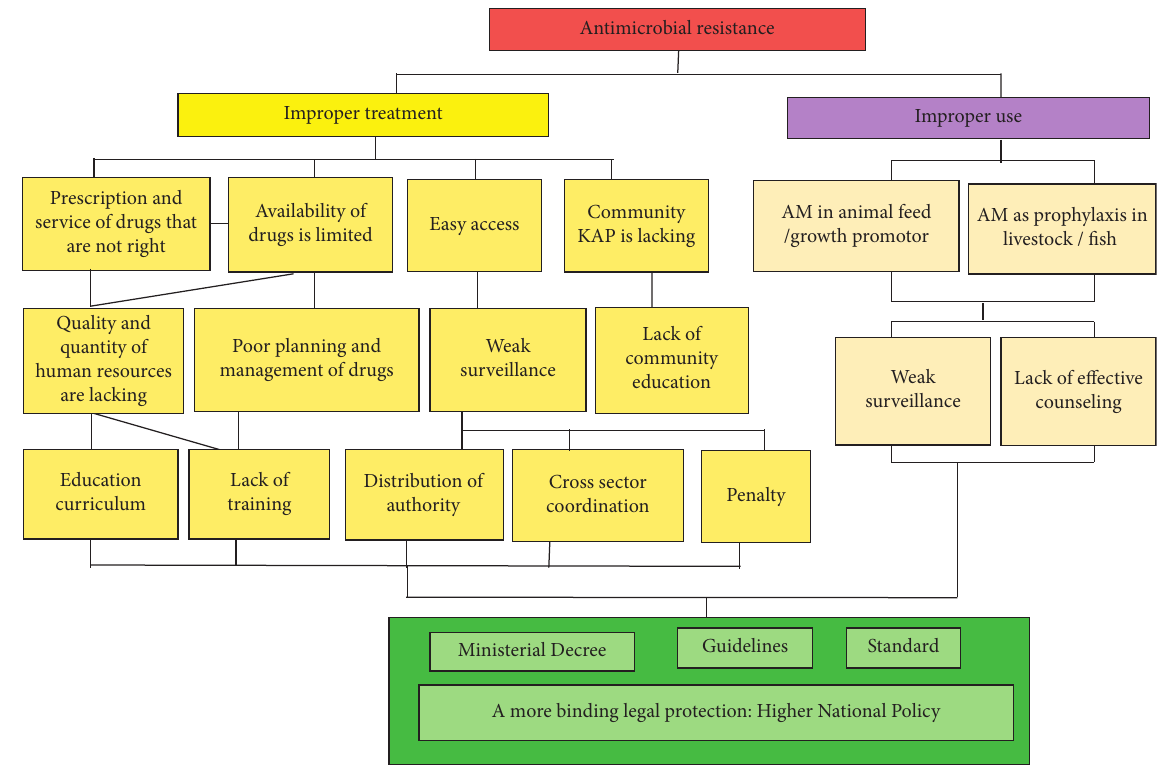
Figure 1: Tree analysis of AMR situation in Indonesia [39]. ∗ KAP: Knowledge, Attitude and